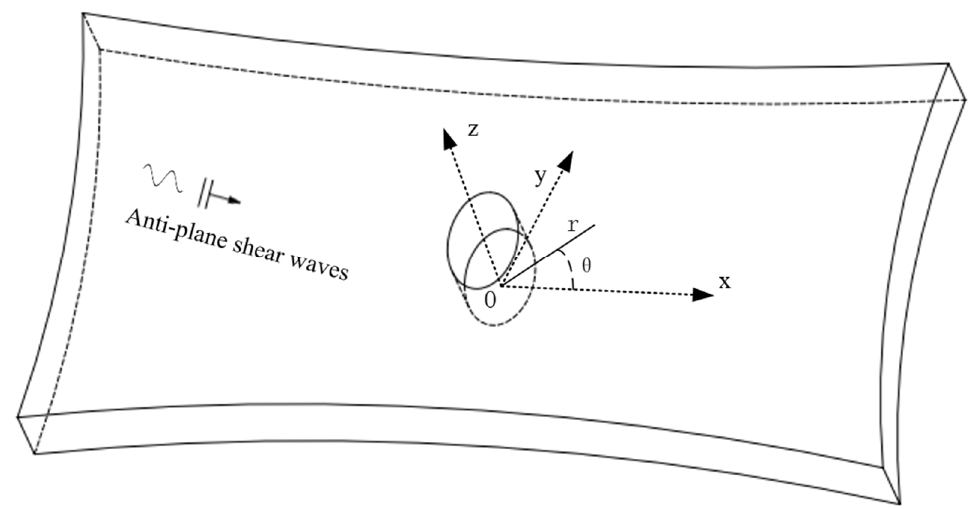
Figure 1. Antiplane shear waves are incident into an elliptical opening of an exponential-gradient piezomagnetic material.